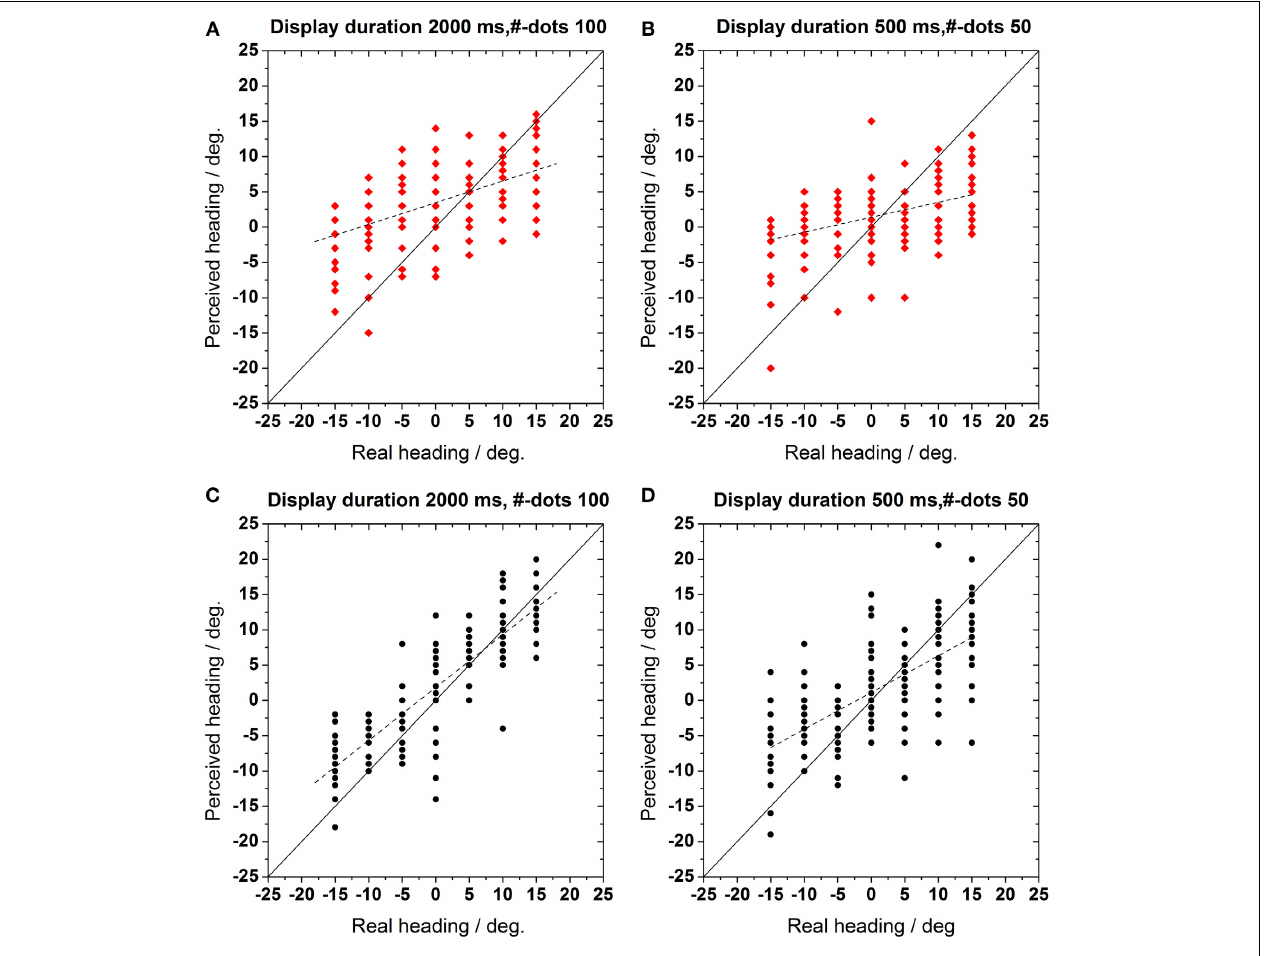
FIGURE 2 | (A,B) Test group ( n = 10 observer) and (C,D) control group ( n = 10 observer): perceived heading direction as function of real motion direction. Here and in the following figures, red symbols show data from the test group, black symbols those from the control group. Each data point